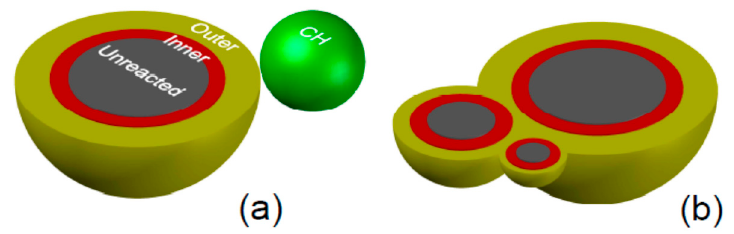
Figure 2. ( a ) Cement hydration products in HYMOSTRUC3D, ( b ) Overlapping of the product layers in particle contacts.